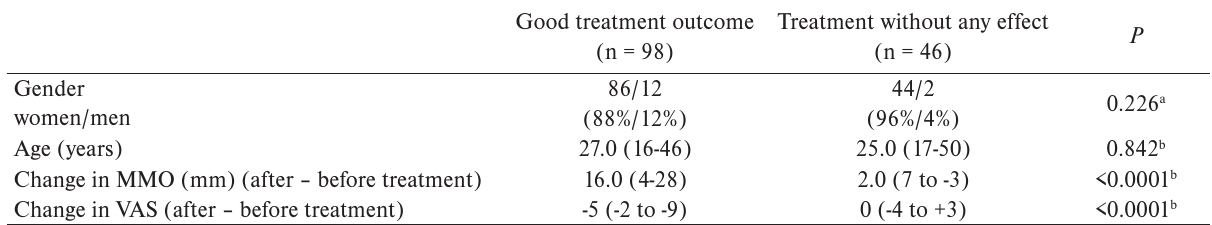
Table 2. A comparison of patients with a good treatment outcome vs. without any treatment effect.